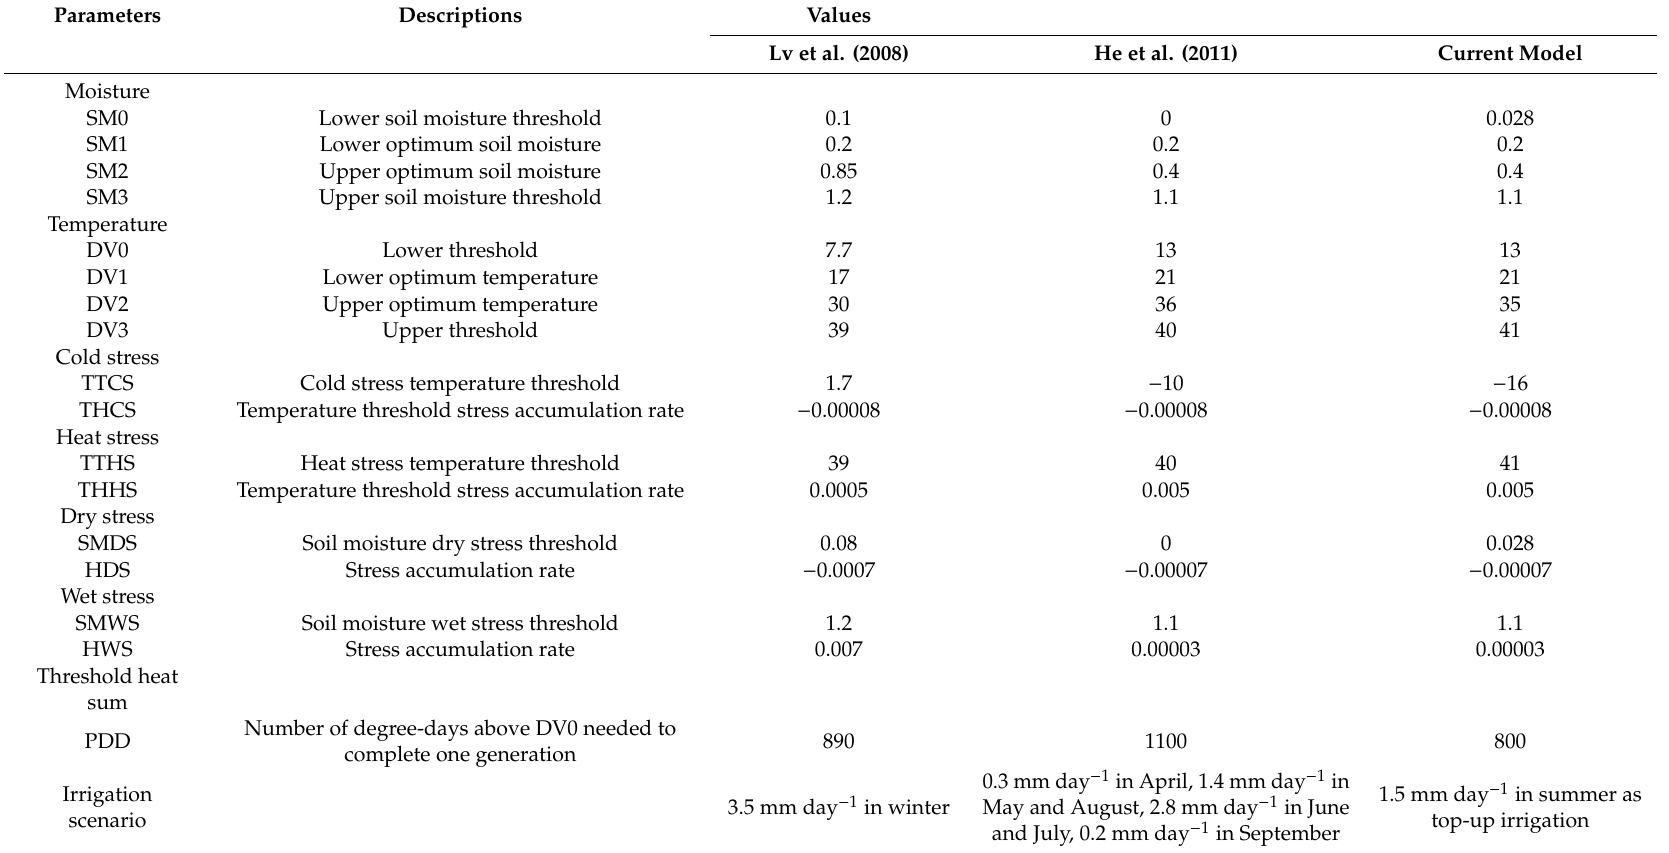
Table 1. CLIMEX parameter values for C.